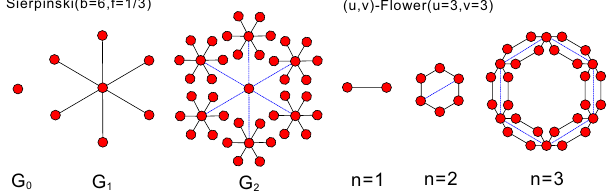
Figure 1. Failure of single (dominant) fractal dimension to capture the heterogeneity in detailed configuration of fractal networks. A comparative example shows. ( a ) Sierpinski fractal network ( s = 1/3, b = 6) and ( b ) (u, v)-flower fractal network ( u = 3, v = 3) share the same fractal dimension (1.631) yet having distinct topological